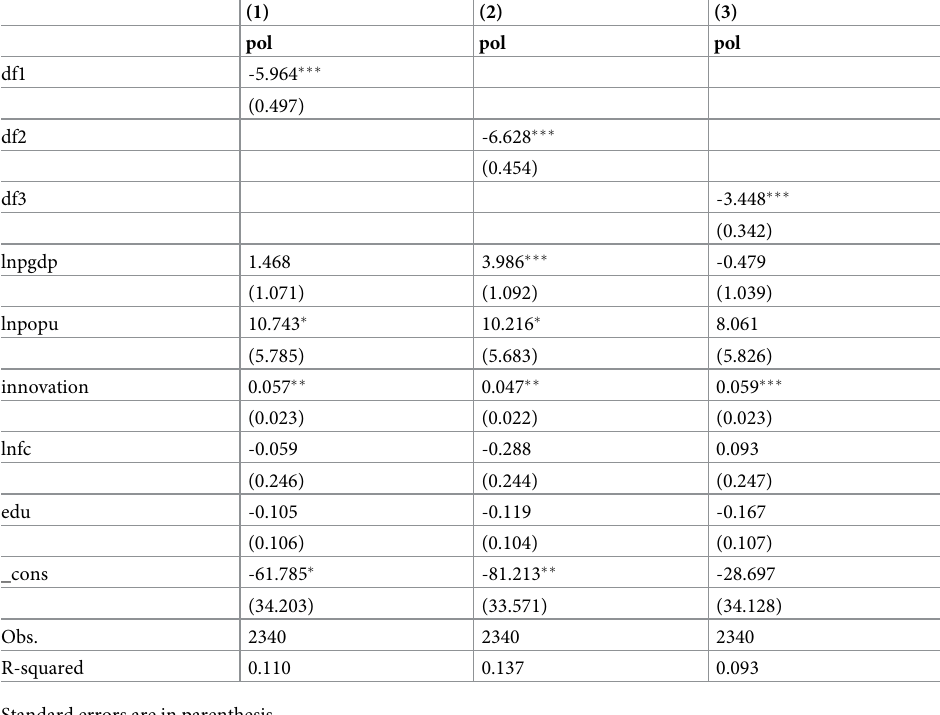
Table 4. Regression results of fixed effects for different dimensions of digital